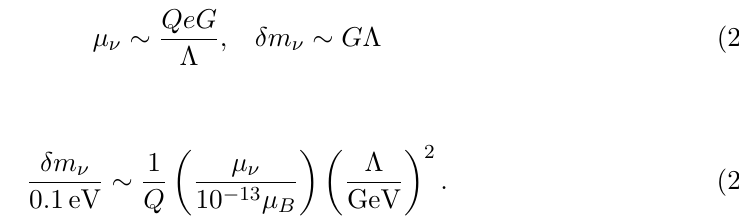
Figure 2 . Higher-loop neutrino mass contribution induced by the presence of the NMM